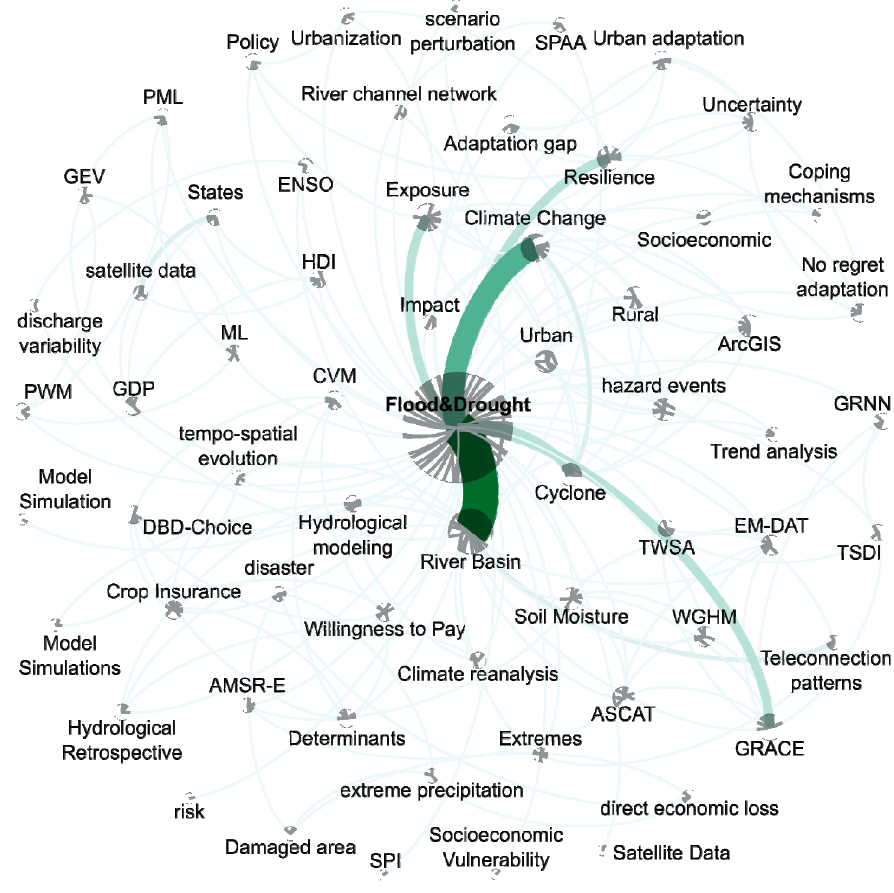
Figure 1. Scientograph of the authors’ keywords around the subjects of flood and drought.